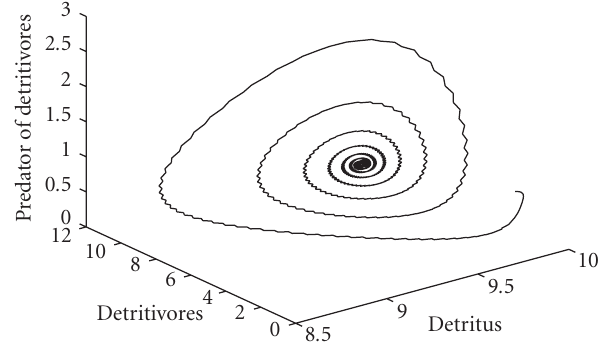
Figure 5.2. Stable phase-space diagram corresponding to Figure 5.1.